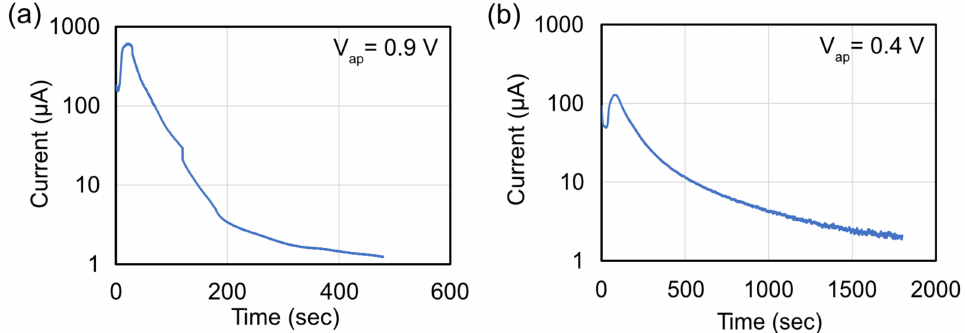
Figure 3. Etch current versus time at V ap of ( a ) 0.9 V and ( b ) 0.4 V. (The discontinuities in ( a ) are caused by stopping the etch to measure AFMs.) At 0.9 V, the etch current has a higher peak and is completed in a shorter amount of